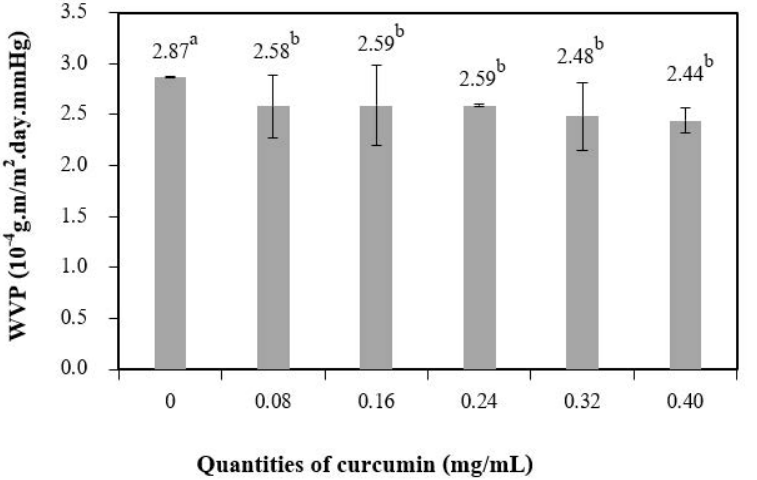
Figure 6. The water vapor permeability of chitosan film incorporated with various curcumin quanti- ties. Results marked with different letters are statistically different ( p <